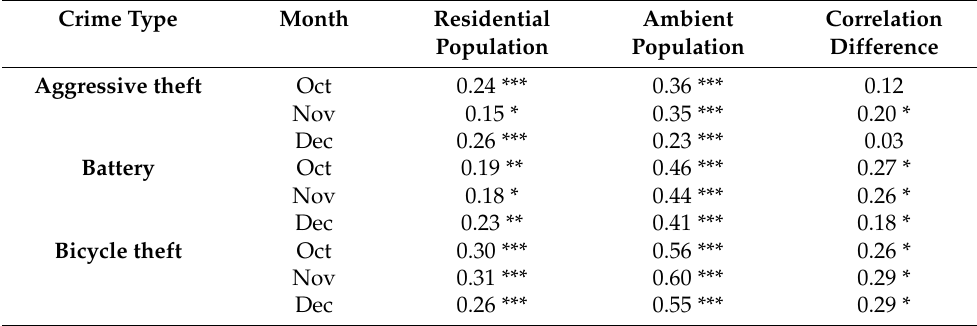
Table 2. Pearson correlation coefficients of crime vs. residential and ambient population (statistical sector level, N = 201). Crime Type